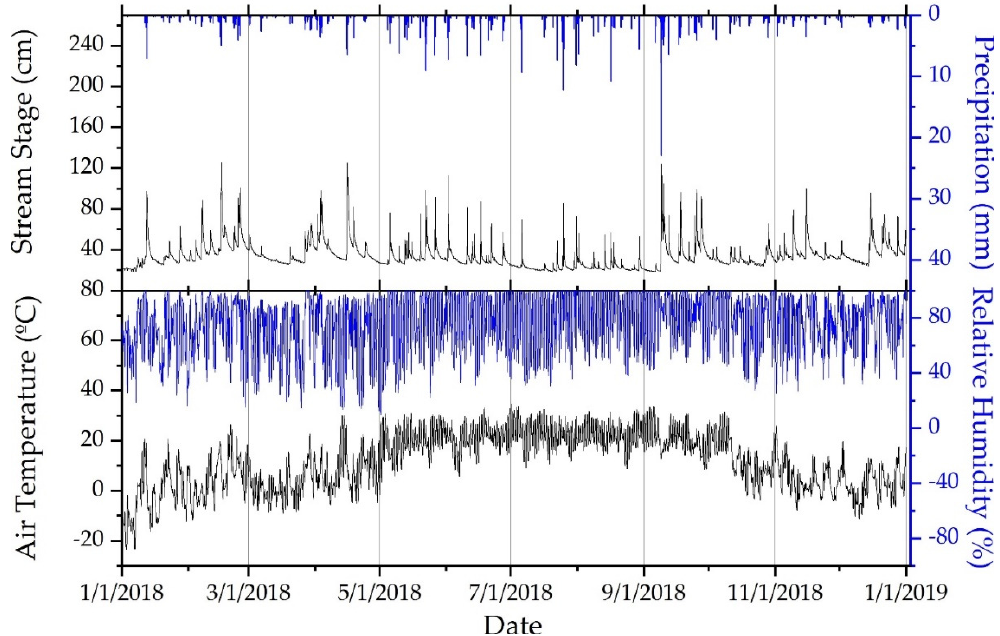
Figure 2. Thirty-minute time series of climate variables during study period (2 January 2018–1 January 2019) in West Run Watershed, West Virginia, USA. Note: Stream stage was monitored in the primary stream of WRW, West Run Creek, at site #13 (Figure